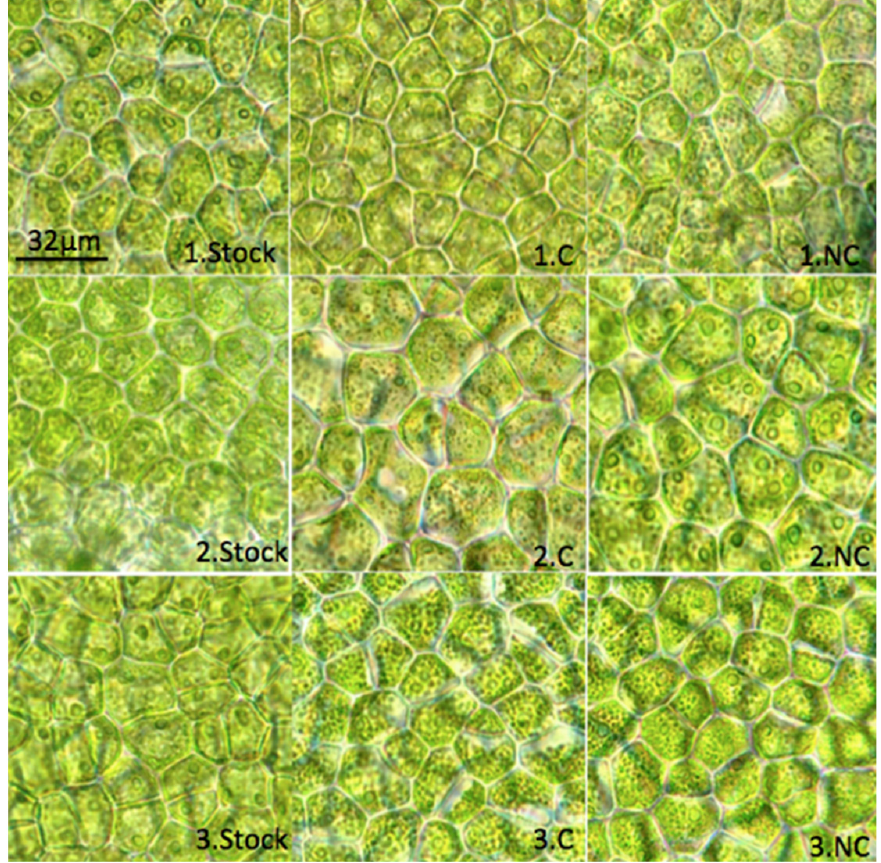
Figure 7. Cellular morphology in superficial view of the initial state and at the end of the culture period in both conditions (controlled (C), uncontrolled (NC)) in the three experiments carried out.